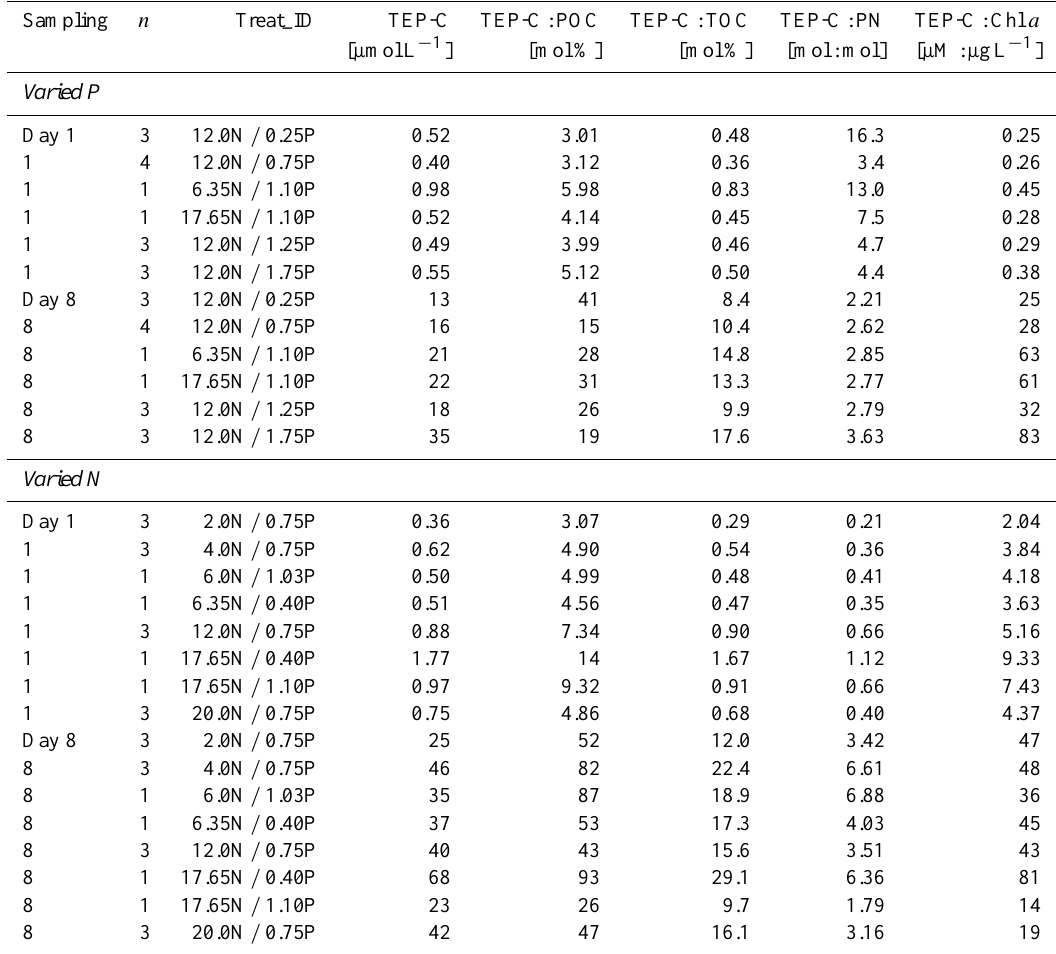
Table 4. Ratios of estimated carbon content of transparent exopolymer particles (TEP-C) to concentrations of particulate organic carbon (POC), total organic carbon (TOC), particulate nitrogen (PN) and Chl a . Average values (mean for TEP-C, median for ratios) are given for replicate treatments on day 1 and 8 during Varied P and Varied N ,